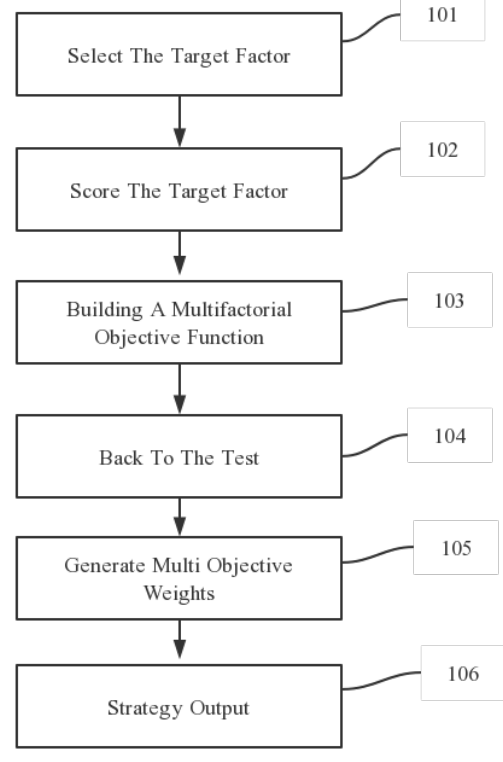
Fig. 1 Quantitative trading strategy generation technology method based on multi-objective optimisation